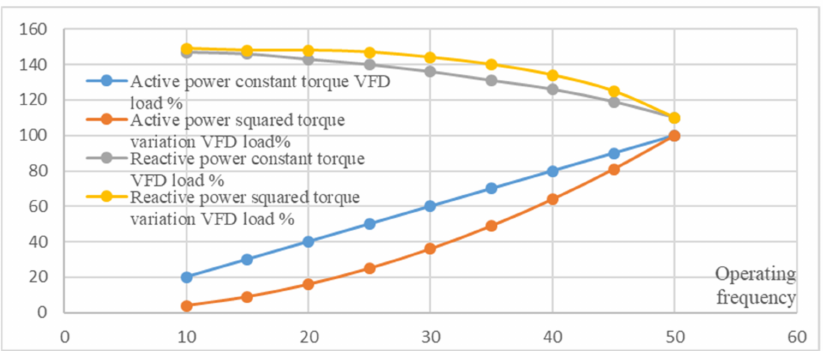
Figure 10. Relative active and reactive power at the point of AC–AC matrix VFD connection to the PDL as a function of the VFD operating frequency in the cases of VFD load with constant torque and squared torque variation.